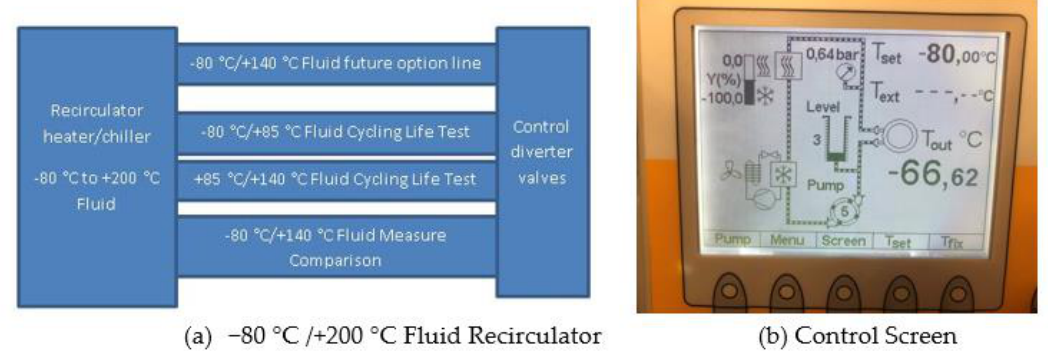
Figure 6. Fluid Recirculator with multiple test protocols. ( a ): Test Setup with −80 °C /+200 °C Fluid Recirculator; ( b ): Control Screen for −80 °C /+200 °C Fluid Recirculator.